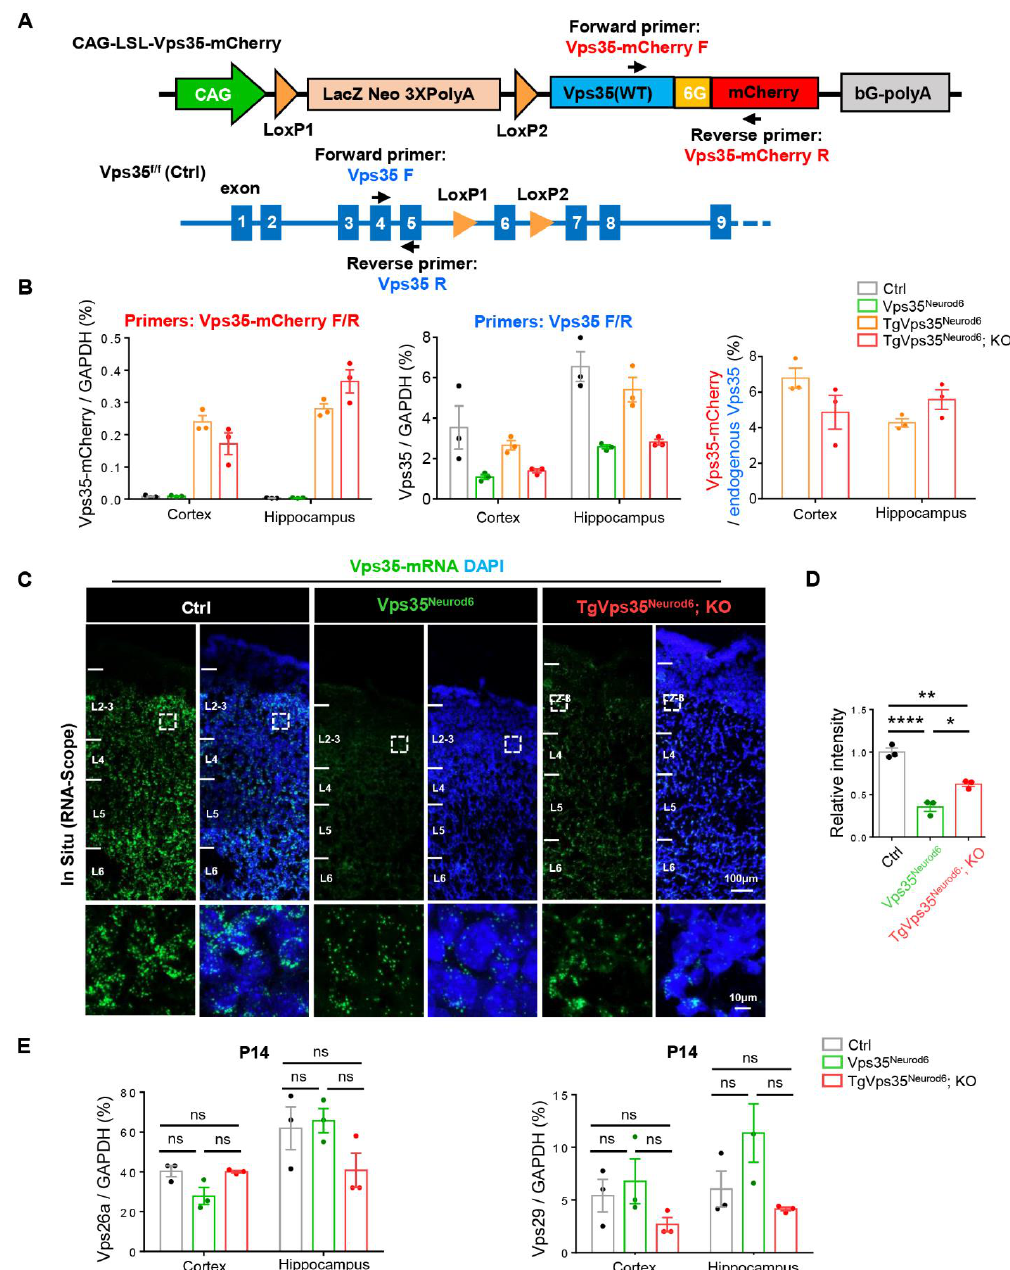
Figure 8. Low level of Vps35-mCherry ’s expression. ( A ) Schematic graph illustrating the primers design for real-time RT- PCR (qRT-PCR) analysis. ( B ) Quantification of Vps35-mCherry and Vps35 mRNA expression in control, Vps35 Neurod6 , TgVps35 Neurod6 and TgVps35 Neurod6 ; KO brains ( n = 3 animals per genotype). ( C ) Representative images of RNA scope analysis of Vps35 mRNAs (green) in control, Vps35 Neurod6 and TgVps35 Neurod6 ; KO cortex. The nuclei were stained with DAPI (blue). ( D ) Quantification analysis of data in ( C ) ( n = 3 animals per genotype; one-way ANOVA with Tukey’s multiple-comparison test). ( E ) Quantification of Vps26a and Vps29 ’s mRNA levels ( n = 3 animals per genotype; one-way ANOVA with Tukey’s multiple-comparison test). Scale bars as indicated in each panel. Individual data points were shown as dots with group mean ± S.E.M; * p < 0.05; ** p < 0.01; **** p < 0.0001; n.s.: Not